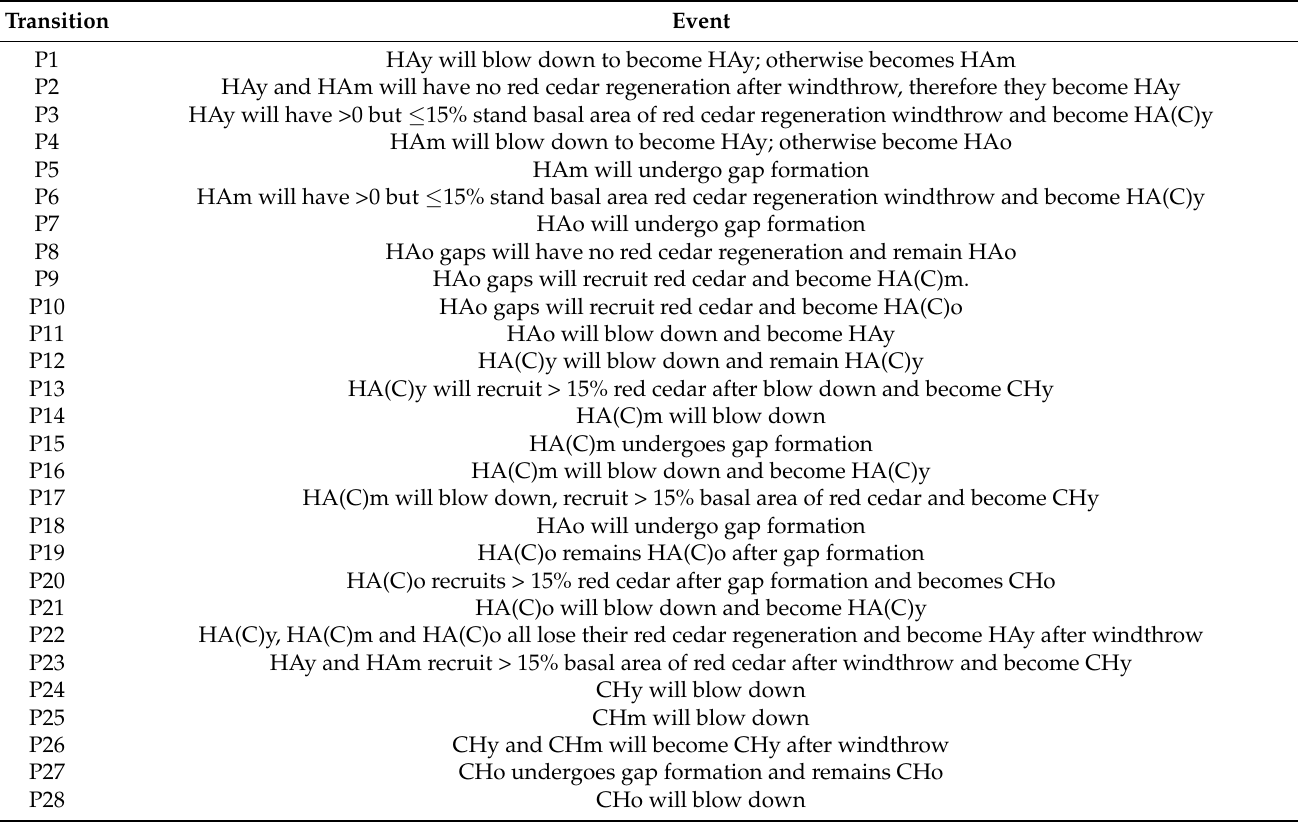
Table 2. Different transitions used to simulate the chain of stochastic events. For their location in the model, see Figure 5. Transition